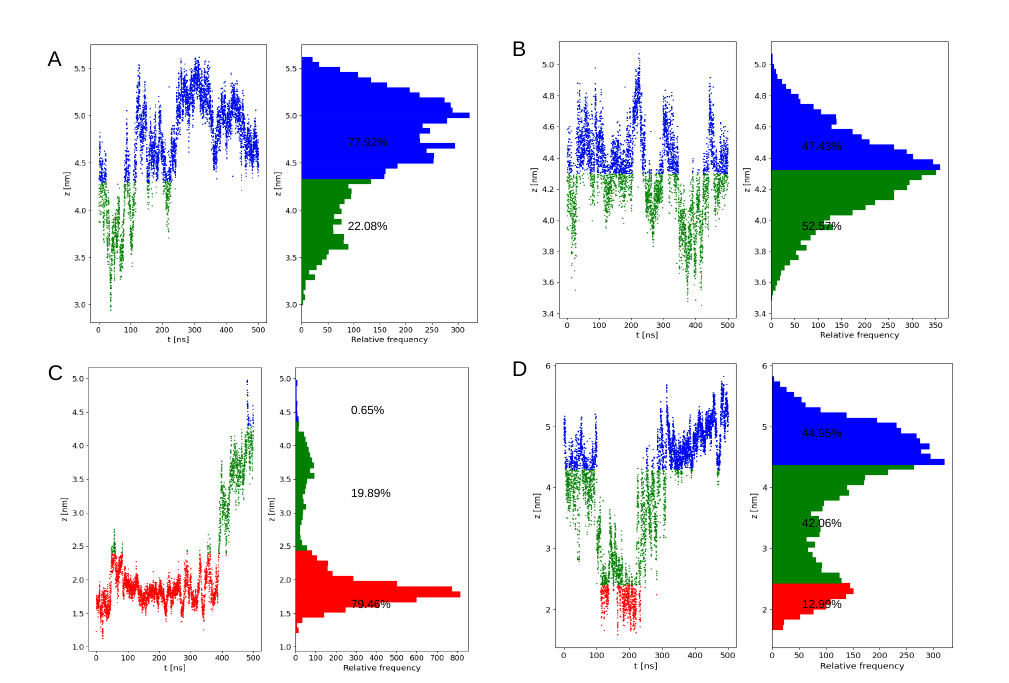
Figure A2. Time evolution of z during the last 500 ns MD simulations of the onc. and wt. KRas-4B-Far proteins for four cases studied in this work. The ratios of the different regions defined in Ref. [20] of the distance are shown on each panel. Three different pools of conformational states are depicted in different colors: z ∈ [0, 2.4) in red, z ∈ [2.4, 4.3] in green, and z ∈ (4.3, 6] in blue. Panel ( A ) refers to onc. chol.-0%, panel ( B ) refers to the wt. chol.-0% system, panel ( C ) stands for the onc. chol.-30% system, and panel ( D ) represents the wt. chol.-30% system, respectively.